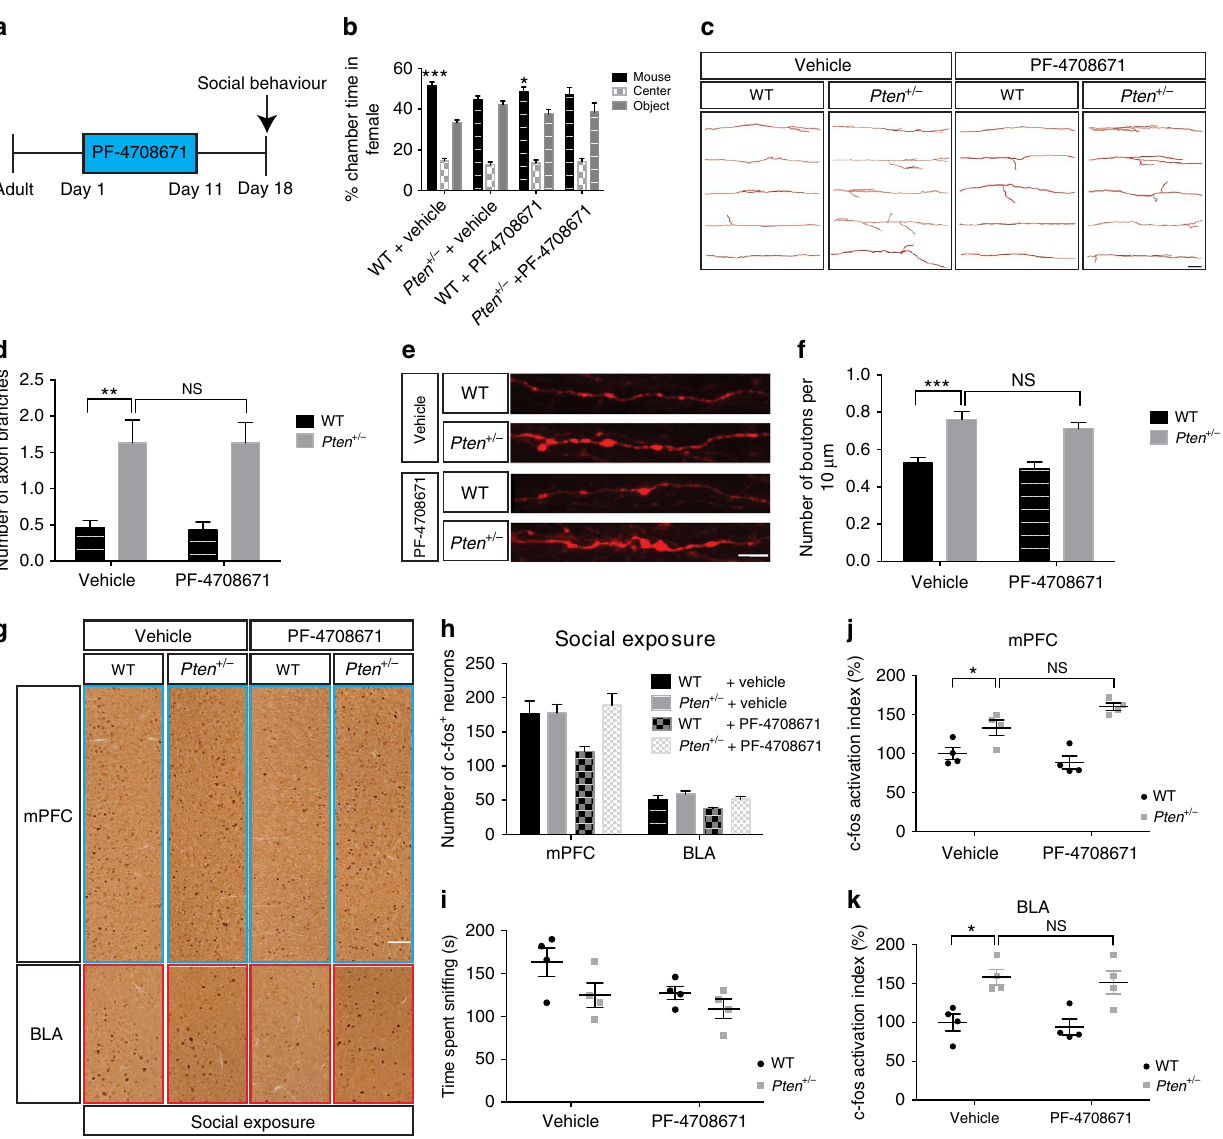
Figure 5 | Inhibition of S6K1 in adulthood does not rescue cellular and behavioural deficits in Pten mutant mice. ( a ) Diagram showing time line of PF-4708671 treatment and testing of social behaviour. ( b ) Graph showing per cent time mice spent in each chamber. Two-way ANOVA and Sidak’s post